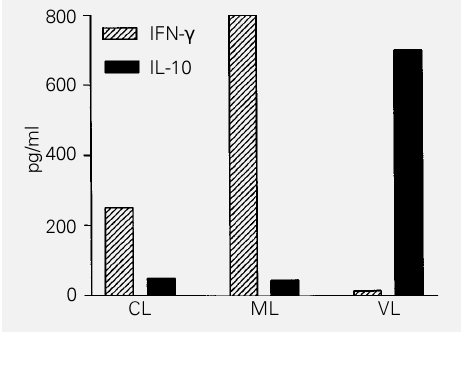
Figure 4 - Effect of IL-10 on the responsiveness of PBMC from tegumentary (CL or ML) leish- maniasis patients. The addition of IL-10 + Leishmania antigen (black bars) diminished lympho- cyte proliferation (proliferation reported as cpm in thousands), IFN-g production (pg/ml in hun- dreds) and cytotoxic responses against K562 tumor target cells (cytotoxicity reported as lytic units (LU) per million PBMC), as compared to cells receiving Leishmania antigen alone (hatched bars). Bars represent the mean – SD of at least six determinations.